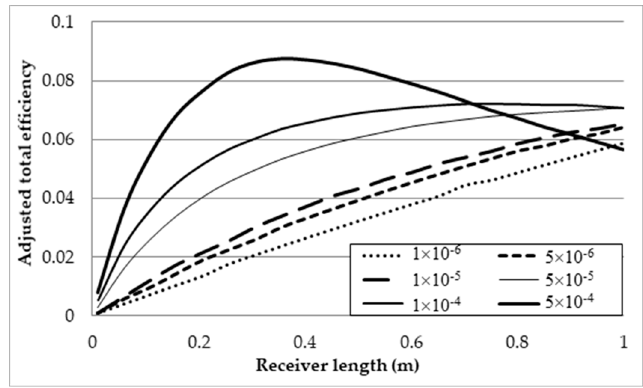
Figure 13. Adjusted total efficiency at different volume fractions.